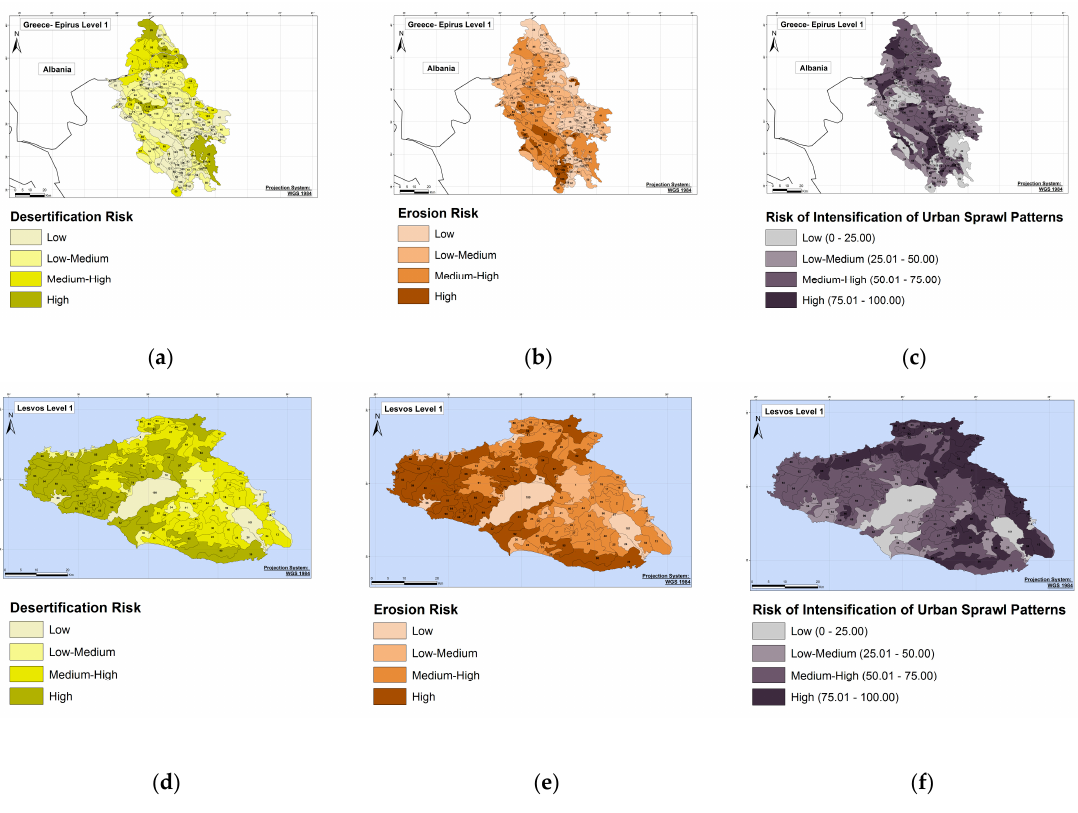
Figure 10. Hazard Maps for LDU’s of Desertification (left), Erosion (middle), and Intensification of urban sprawl (right) in Greece: Epirus ( a – c ) and Lesvos ( d – f ).